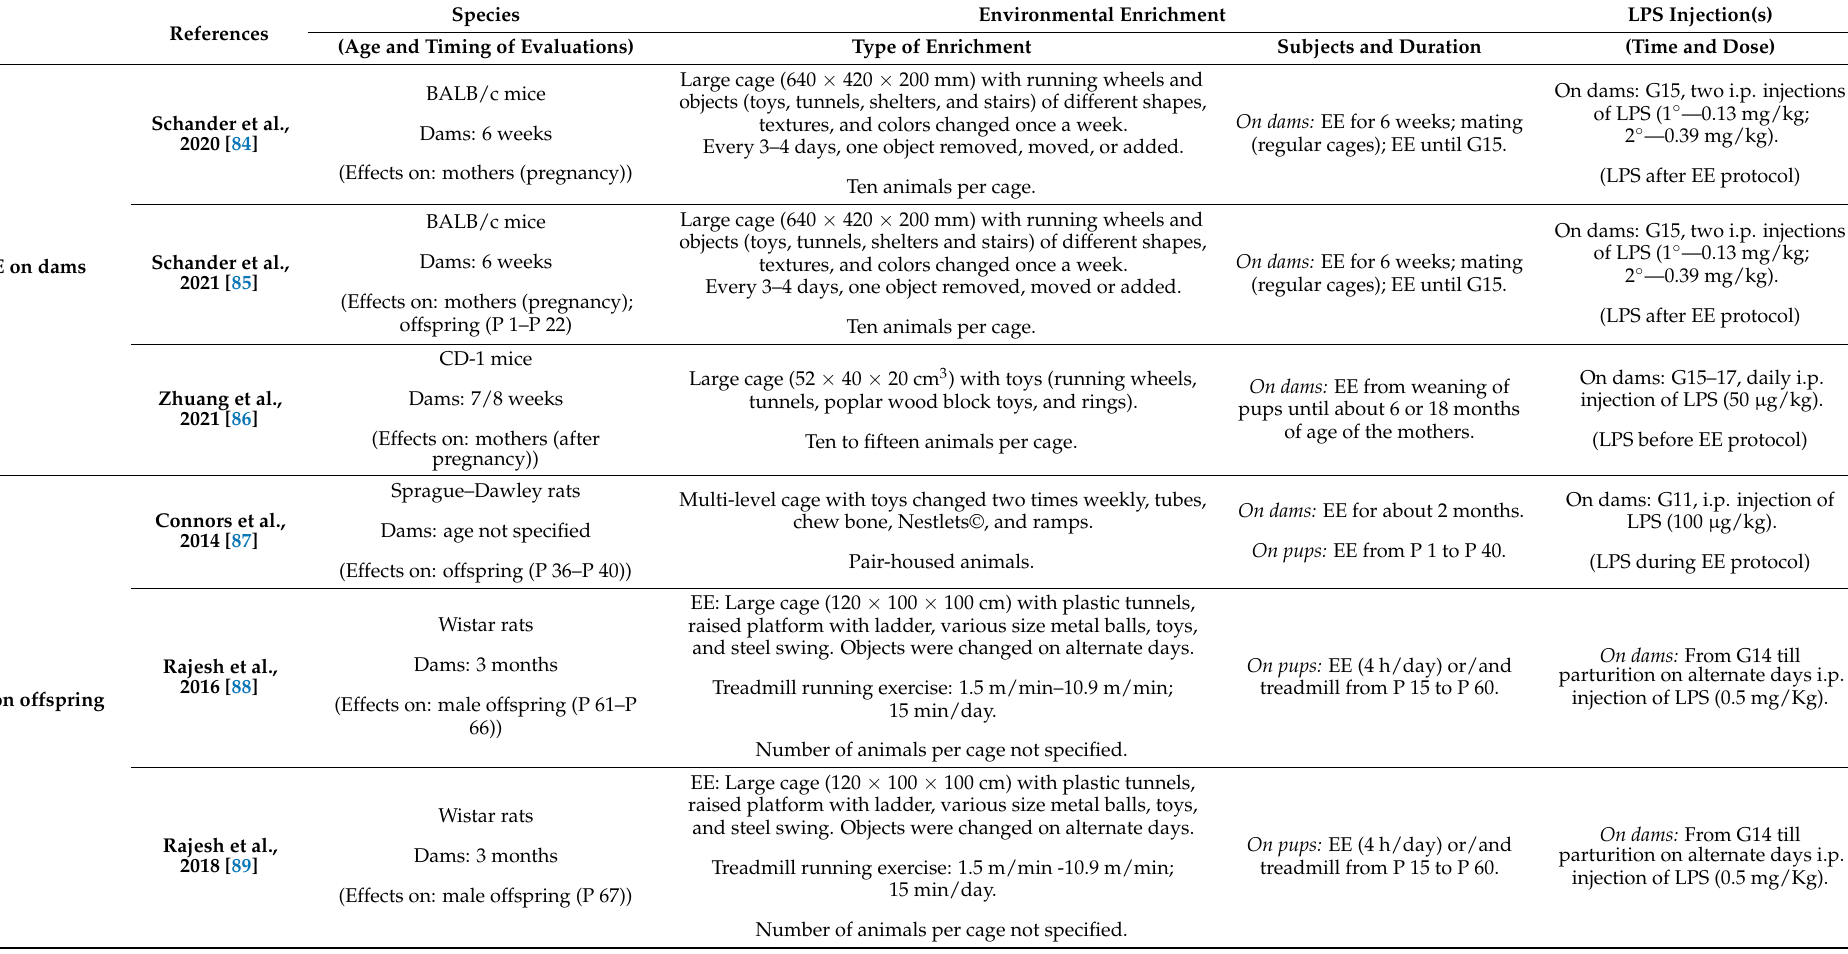
Table 1. Prenatal inflammation—study